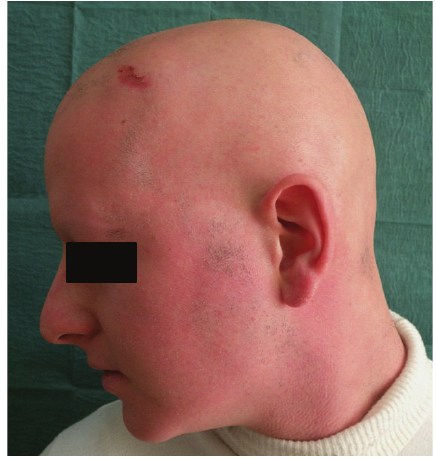
Figure 3: AA of scalp, beard, eyelashes, and eyebrows in patient a ff ected by CD.